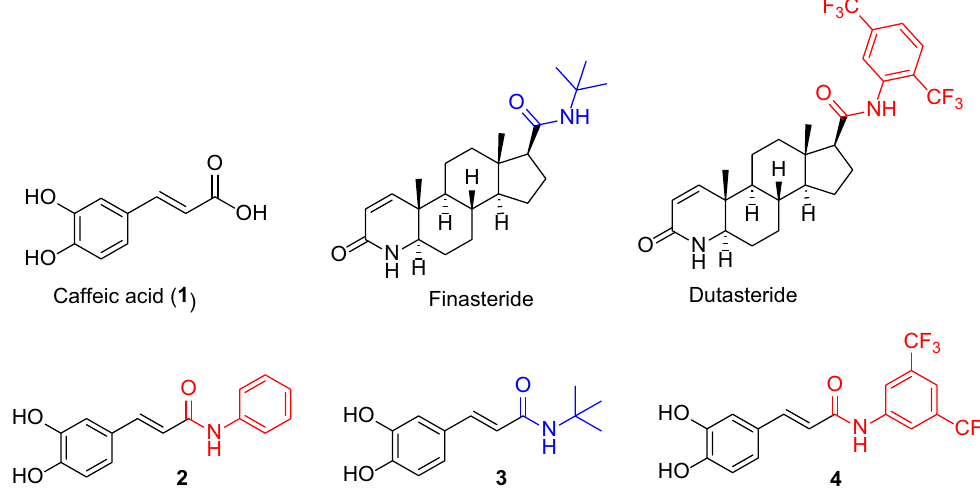
Figure 1. Structure of caffeic acid ( 1 ), its amide derivatives ( 2 − 4 ) and steroid 5α-reductase inhibited drugs, finasteride and dutasteride.